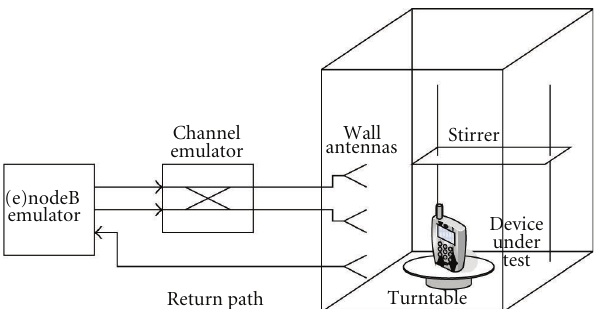
Figure 8: Test bench configuration for test using channel emulator and reverberation chamber for a 2 × 2 MIMO configuration TR 37.976 [7] Figure 6 . 3 . 2 . 2 .